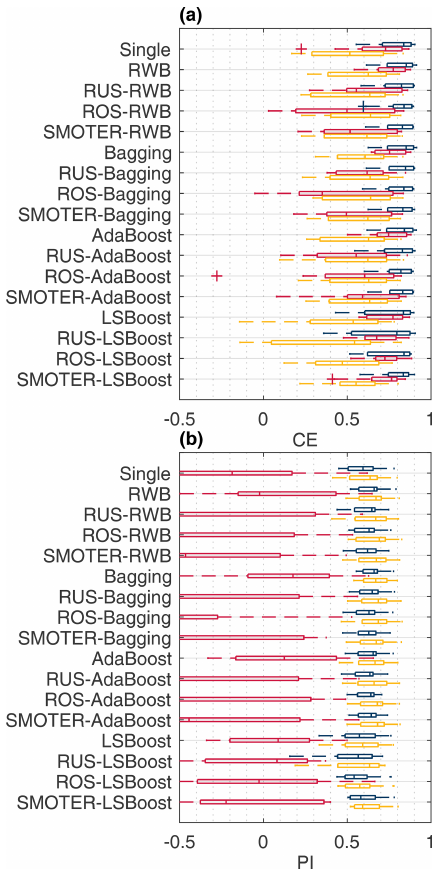
Figure 8. Overall (blue), typical stage (red), and high stage (yellow) CE (a) and PI (b) for the Don River models.